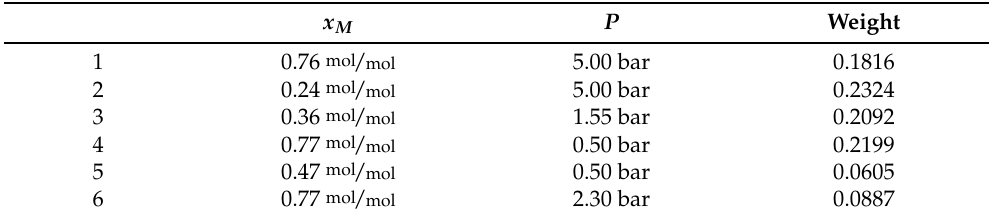
Table 6. Optimal design ξ VDM computed with the vertex direction method (VDM) for the flash with a methanol–acetone input feed.